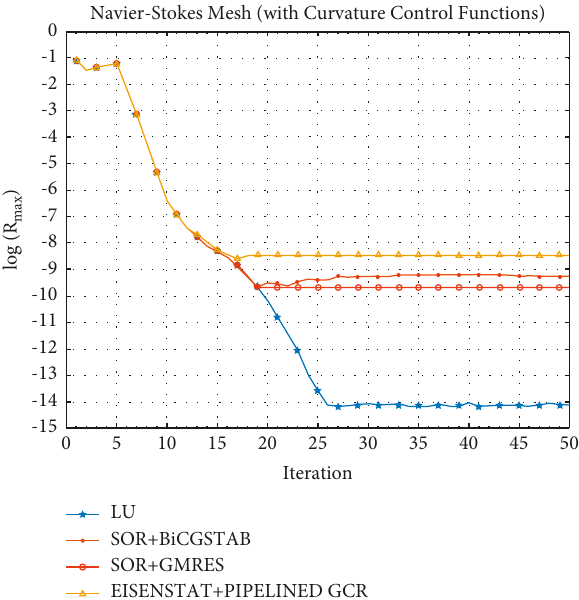
Figure 17: Convergence of the Navier–Stokes mesh vs. iteration, with curvature functions.